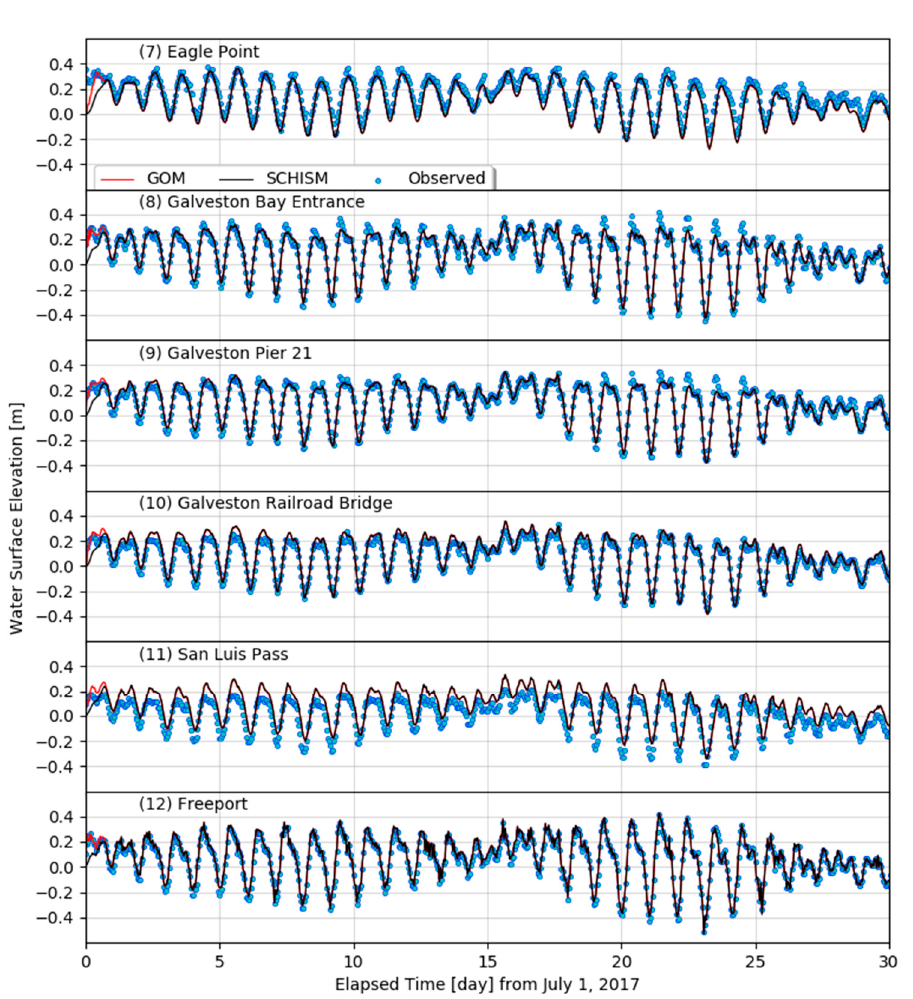
Figure 19. Water surface elevation comparison between measurements (blue circles), GOM simulation results (solid red lines), and SCHISM simulation results (solid black lines) from tide stations 7 to 12. Table 3. Error analysis of the surface elevation simulation for both the SCHISM and GOM.